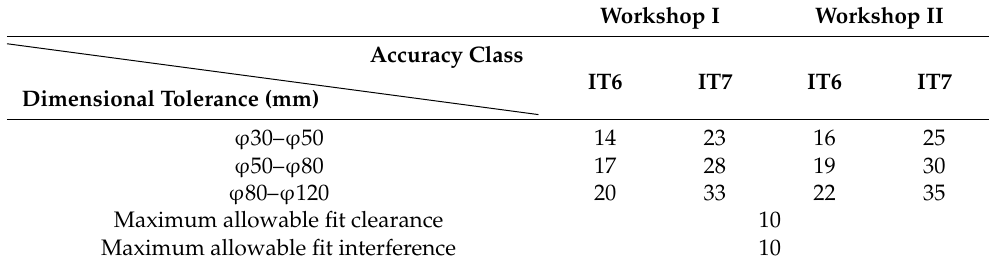
Table 10. Production process statistics table in the knowledge base.